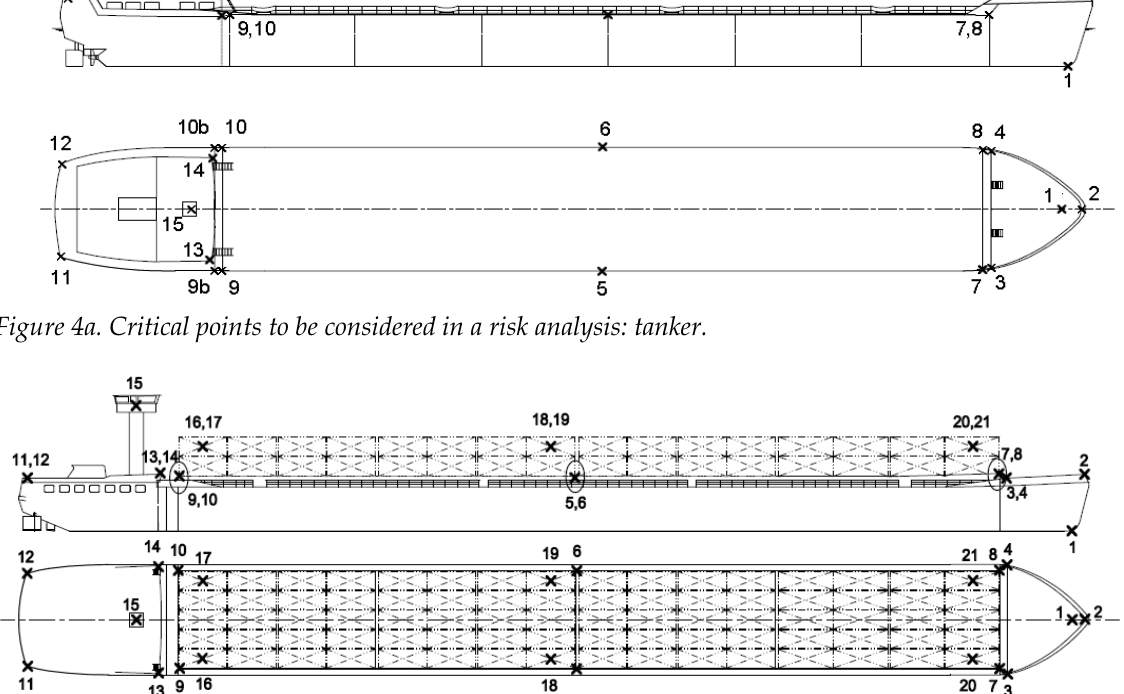
Figure 4b. Critical points to be considered in a risk analysis: container